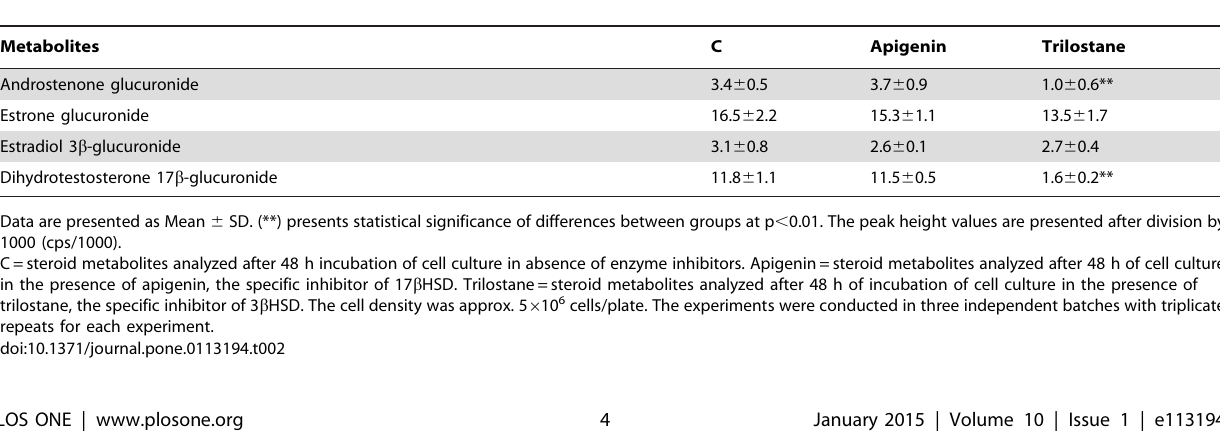
Table 2. Peak heights (cps) of the ion chromatograms of steroids metabolites in cell culture medium.